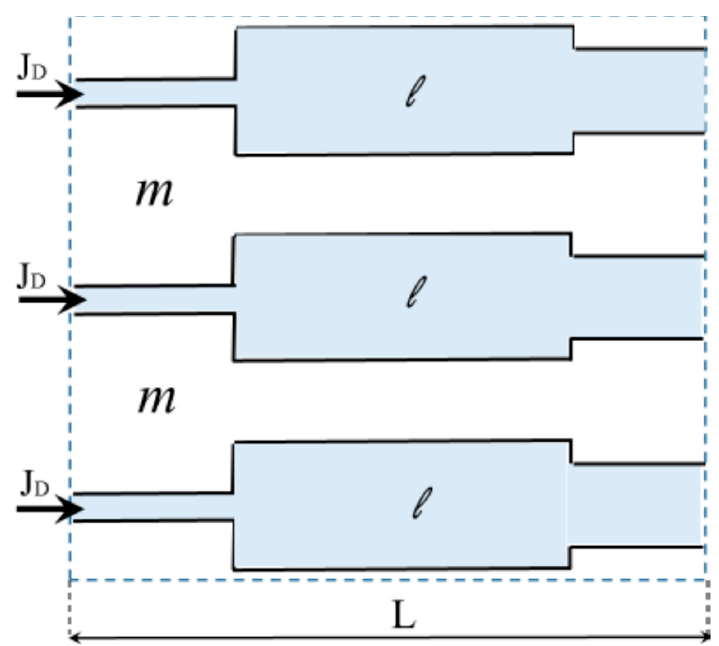
Figure 9. A sketch of porous material represented as a composite of solid matrix (index “ m ”) and tortuous channels filled with liquid (index “ l ”).